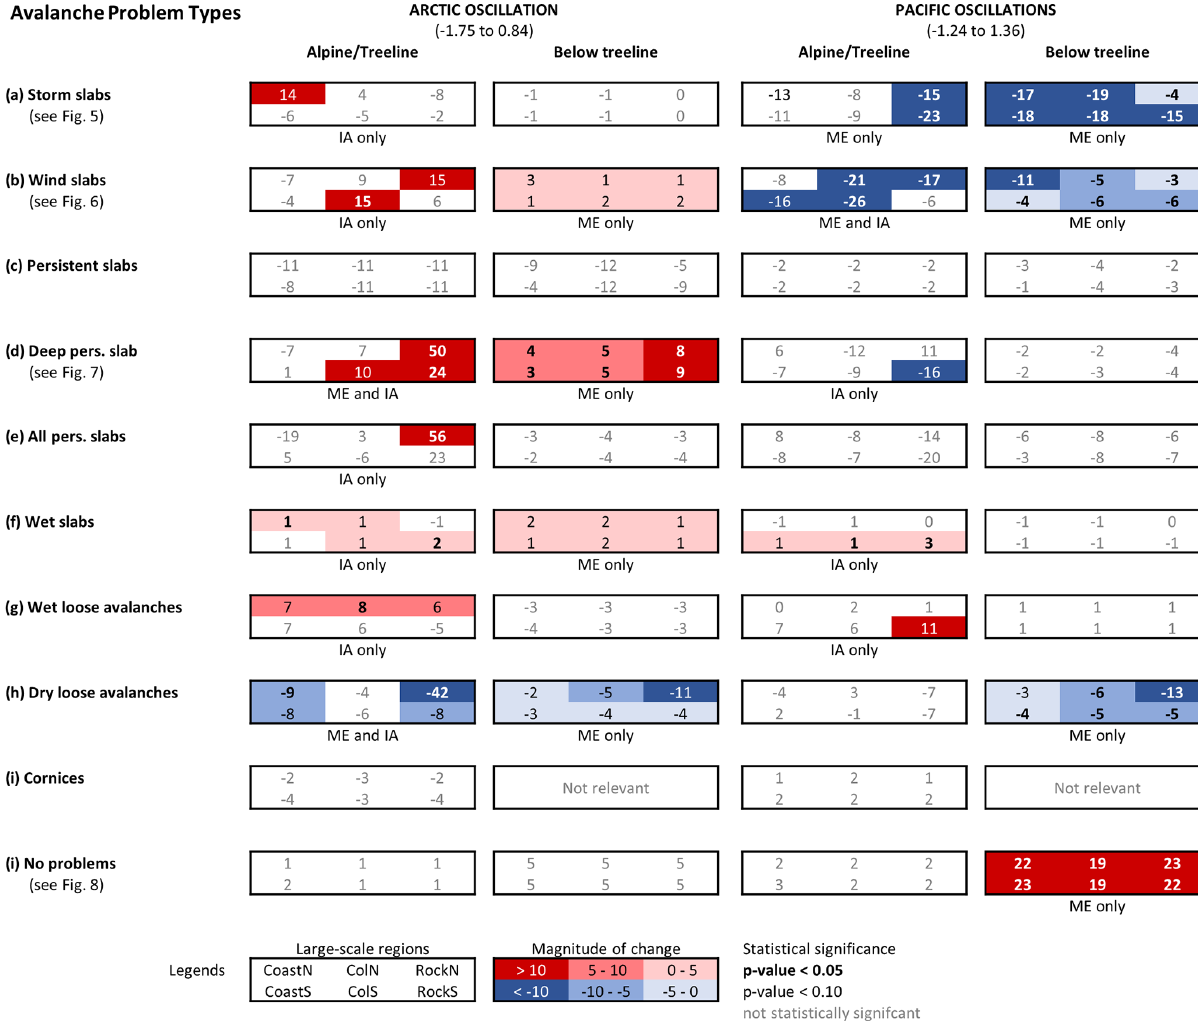
Figure 4. Overview of the effect of the examined atmospheric oscillations on the prevalence values of avalanche problem types expressed as change in percentage points over the range of the observed oscillation indices (i.e., difference in marginal mean estimates). For each avalanche problem type and elevation band (alpine/treeline and below treeline) the six percentage point values are arranged to roughly represent their geographic arrangement. Font and colour of the percentage point labels describe the statistical significance of the difference: bold and black/white: p < 0 . 05; black/white only: 0 . 05 ≤ p < 0 . 10; grey: not statistically significant. The shading of the cell indicates the magnitude of any significant percentage point differences: dark blue: < − 10pp; medium blue: − 10 to − 5pp; faint blue: − 5 to 0pp; faint red: 0 to 5pp; medium red: 5 to 10pp; dark red: > 10pp. The labels underneath the boxes indicate whether the model includes the main (ME) and/or interaction effects